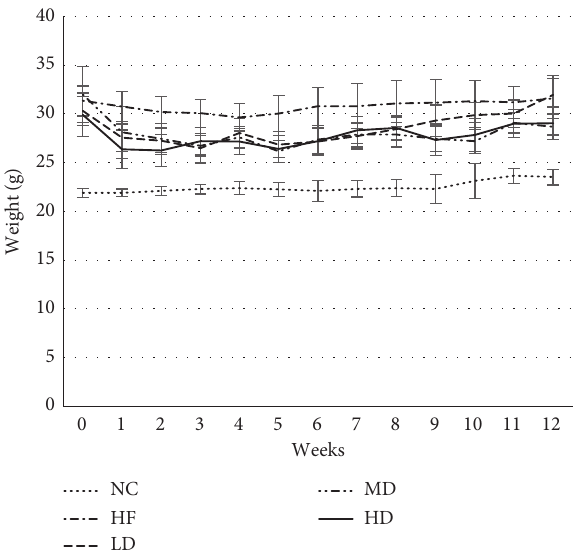
Figure 2: Changes in weight for 12weeks (means ± SD, g). ∗ Compared with the HF group, the difference was statistically significant ( P < 0 .